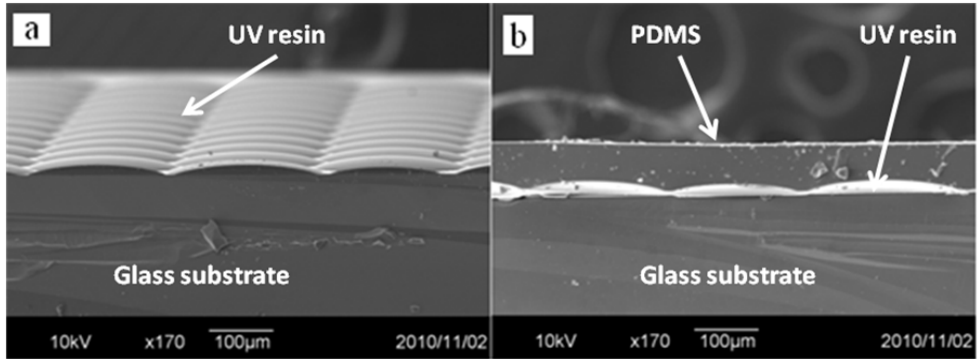
Figure 6. SEM image of the UV-resin MLA (a) without and (b) with the second layer of PDMS.